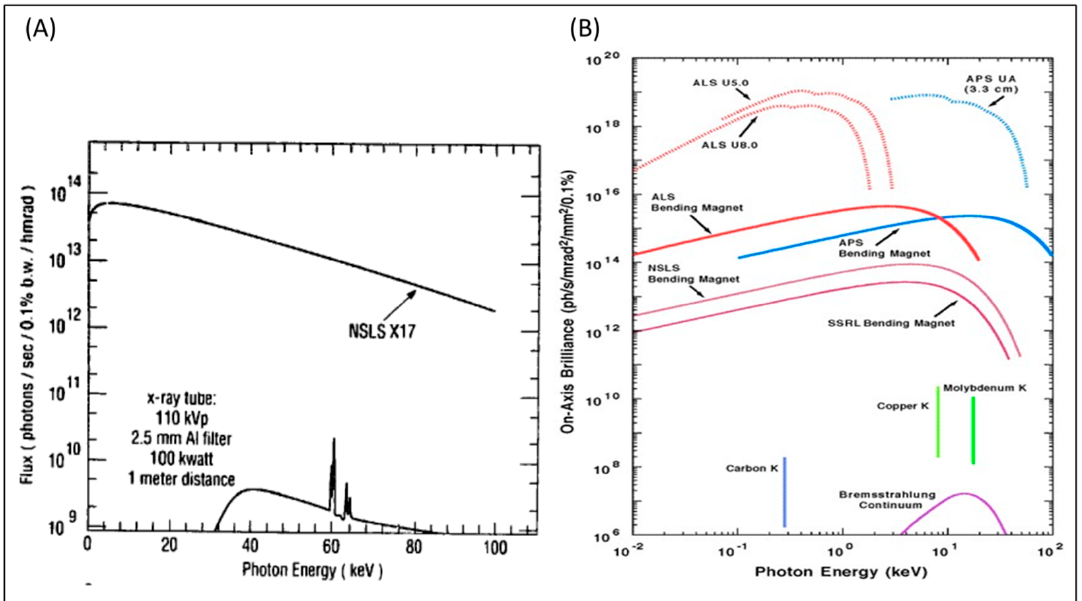
Figure 2. ( A ) SXR spectrum from the X17 superconducting wiggler beam port at the National Synchrotron Light Source (NSLS) in comparison to a high-power conventional X-ray tube source. Reprinted with permission from [5]. ( B ) Brilliance of emitted photons (photons/sec/mrad 2 /mm 2 /0.1%) vs. energy of the emitted photon (KeV) for different sources. U in the figure refers to an undulator. Figure courtesy of Argonne National Laboratory and reprinted with permission from [6]. The range of photon energy is from UV (10 1 eV) up to hard X-rays (10 5 eV). The vertical lines at the bottom of the figure represent K emission and the bottom curve represent bremsstrahlung that is typical for all X-ray tubes that are restricted to a small range of wavelengths with low brilliance. The SXR emissions, compared to the other sources, are several orders of magnitude higher and for a broader set of frequencies (represented in logarithmic scale in both x and y axes) [7].